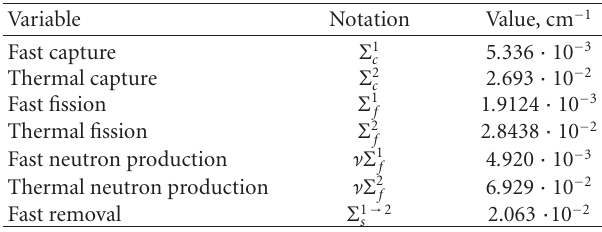
Table 1: Assembly homogenized 2-group cross-sections [21].